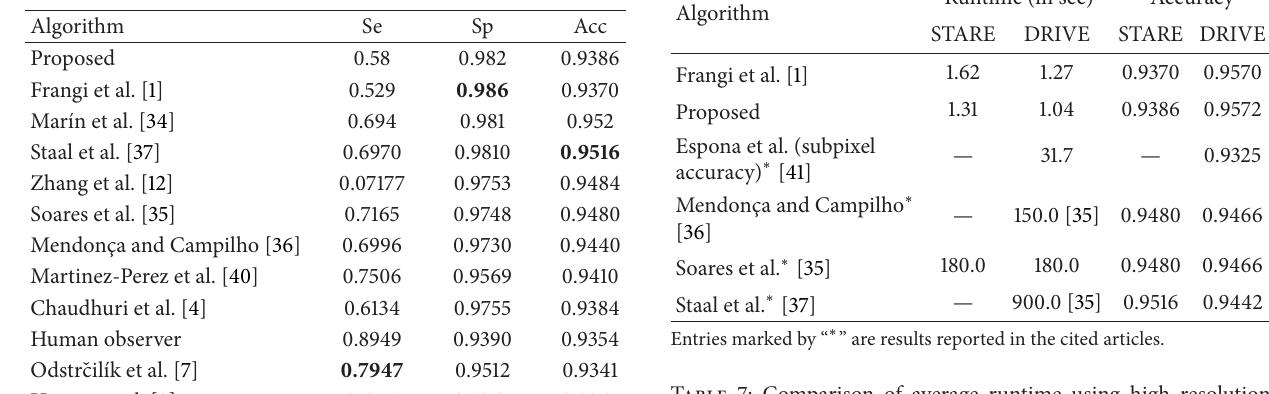
Table 7: Comparison of average runtime using high resolution ( 3504 × 2336 )